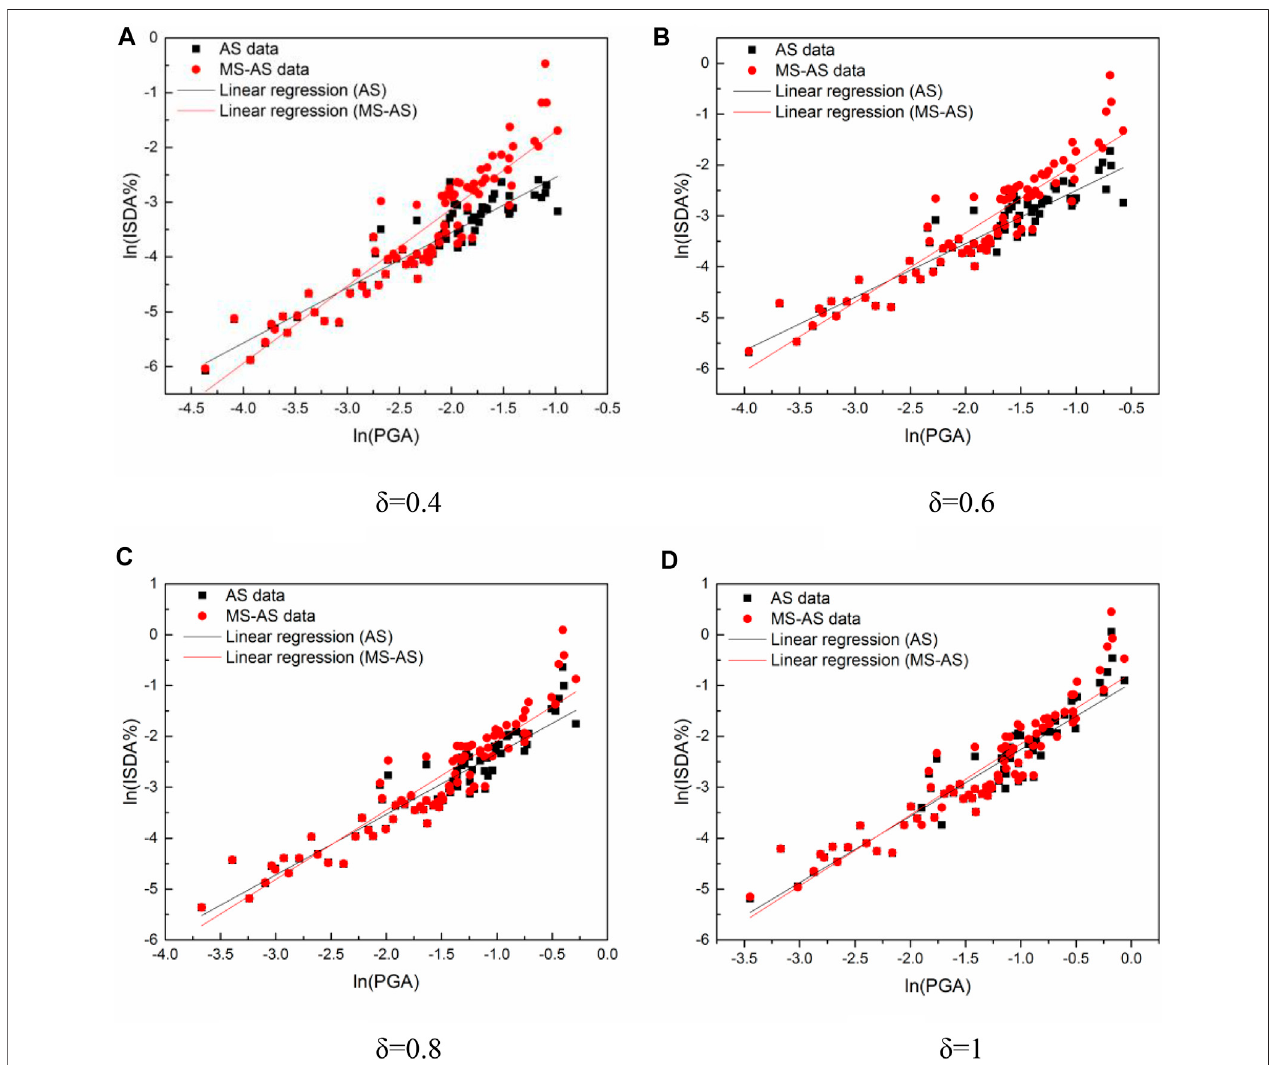
FIGURE 9 | Probabilistic seismic demand model of CM subjected to aftershock. (A) δ (cid:2) 0.4 (B) δ (cid:2) 0.6 (C) δ (cid:2) 0.8 (D) δ (cid:2) 1.